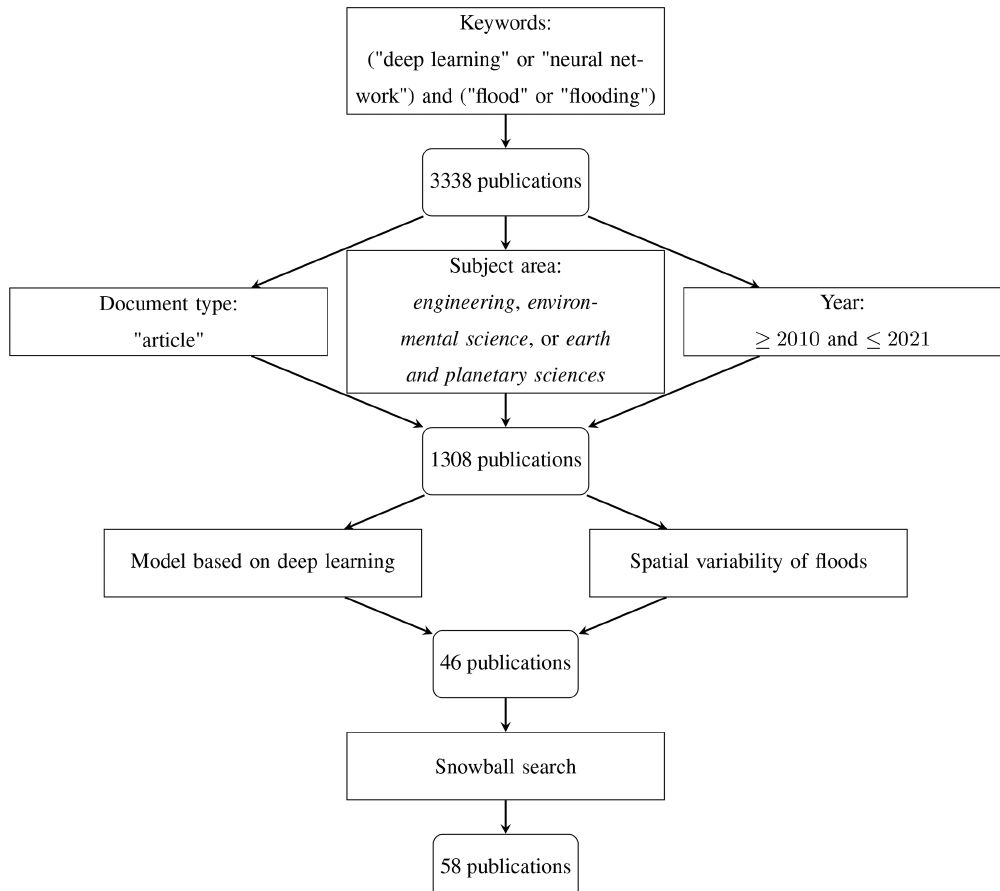
Figure 3. Flowchart of the methodology applied for the paper